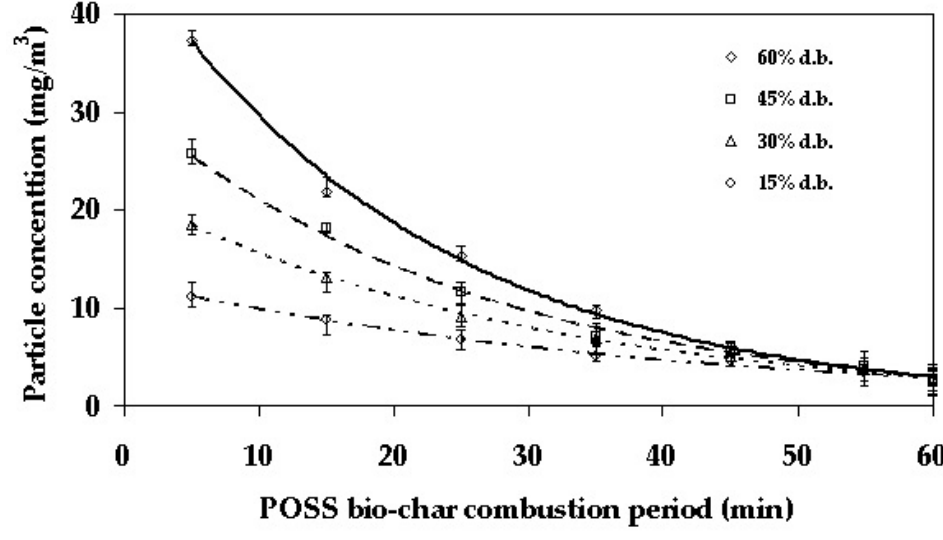
Figure 6. MMAD emission from the POSS bio-char combustion for different moisture contents.